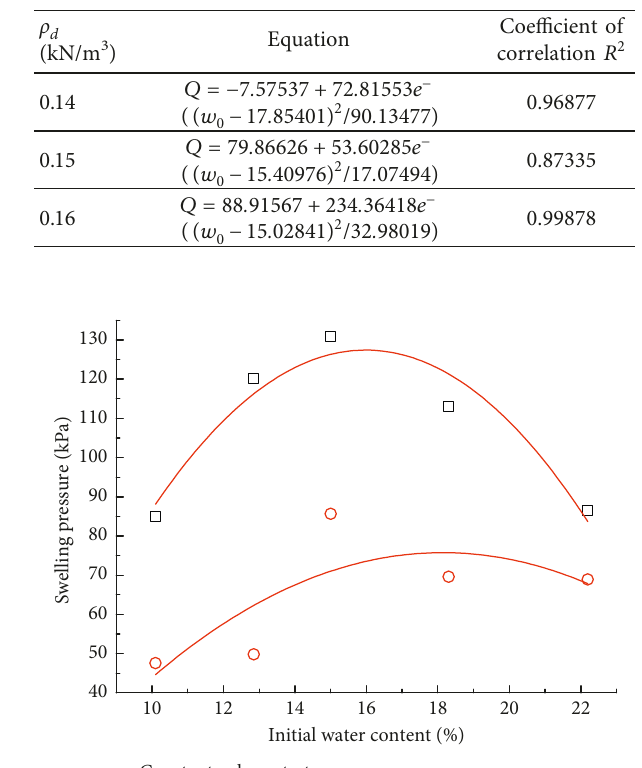
Table 5: Fitting equations for relation of expansive pressure and water content.